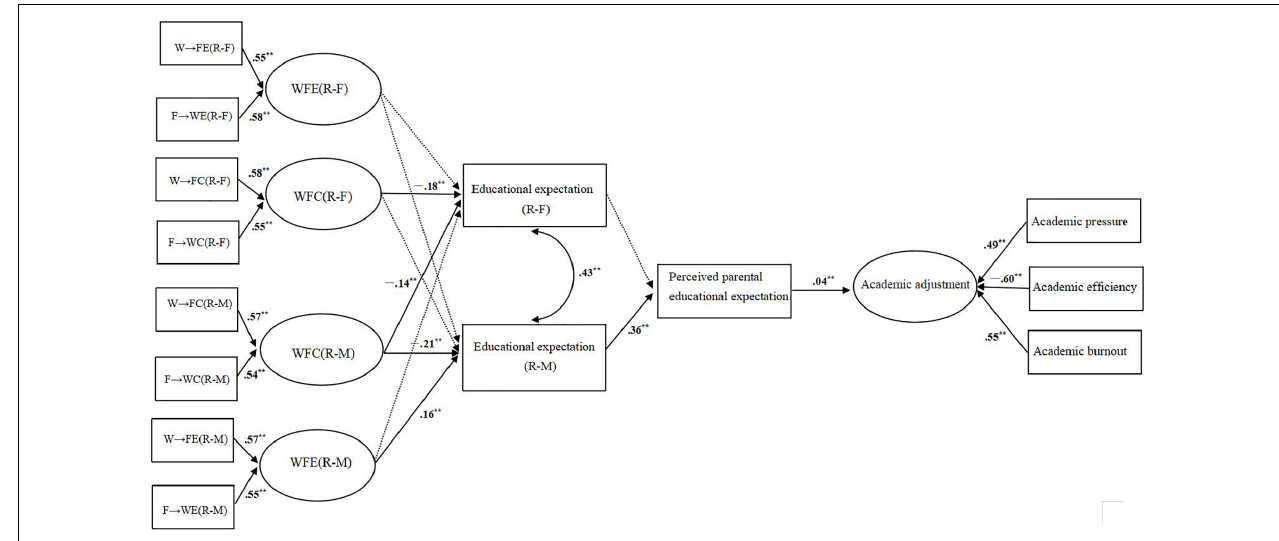
FIGURE 1 | The mediated impact of parental educational expectation and perceived educational expectation on WFC, WFE, and academic adjustment, final model. W → FC, work → family conflict; F → WC, family → work conflict; W → FE, work → family enrichment; F → WE, family → work enrichment. Solid arrows indicate significant paths; dotted arrows indicate not significant paths: Standardized estimates are depicted. * p < 0.05, ** p <